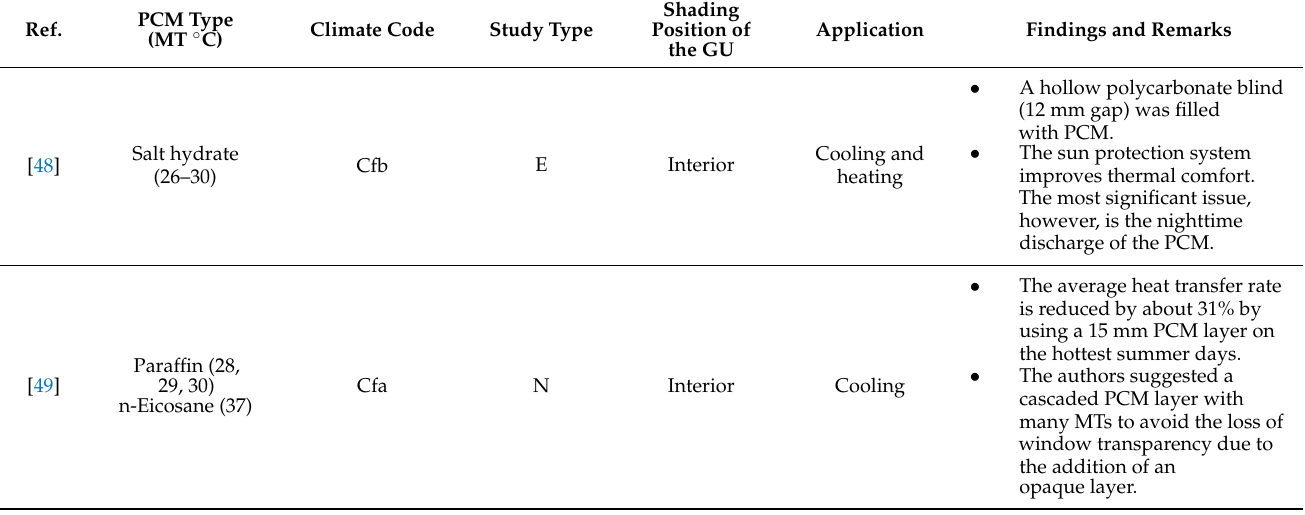
Table 4. Summary of PCM-incorporated shading systems of